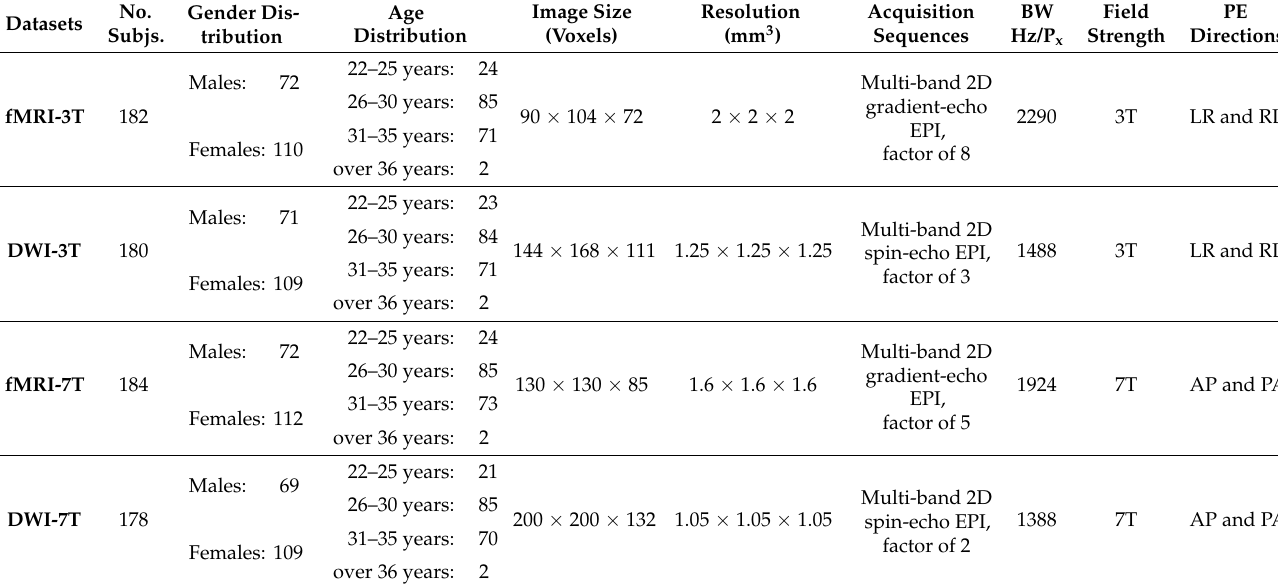
Table 1. A summary of the datasets used in the